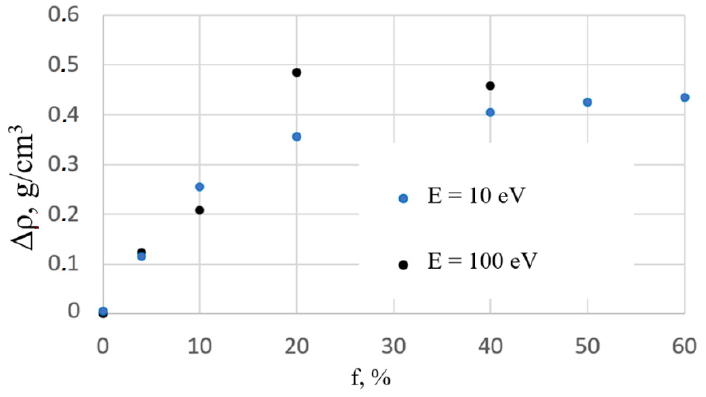
Figure 3. Atomistic structure of deposited films for various fractions of assisting oxygen atoms, f; energy of assisting ions E = 100 eV.